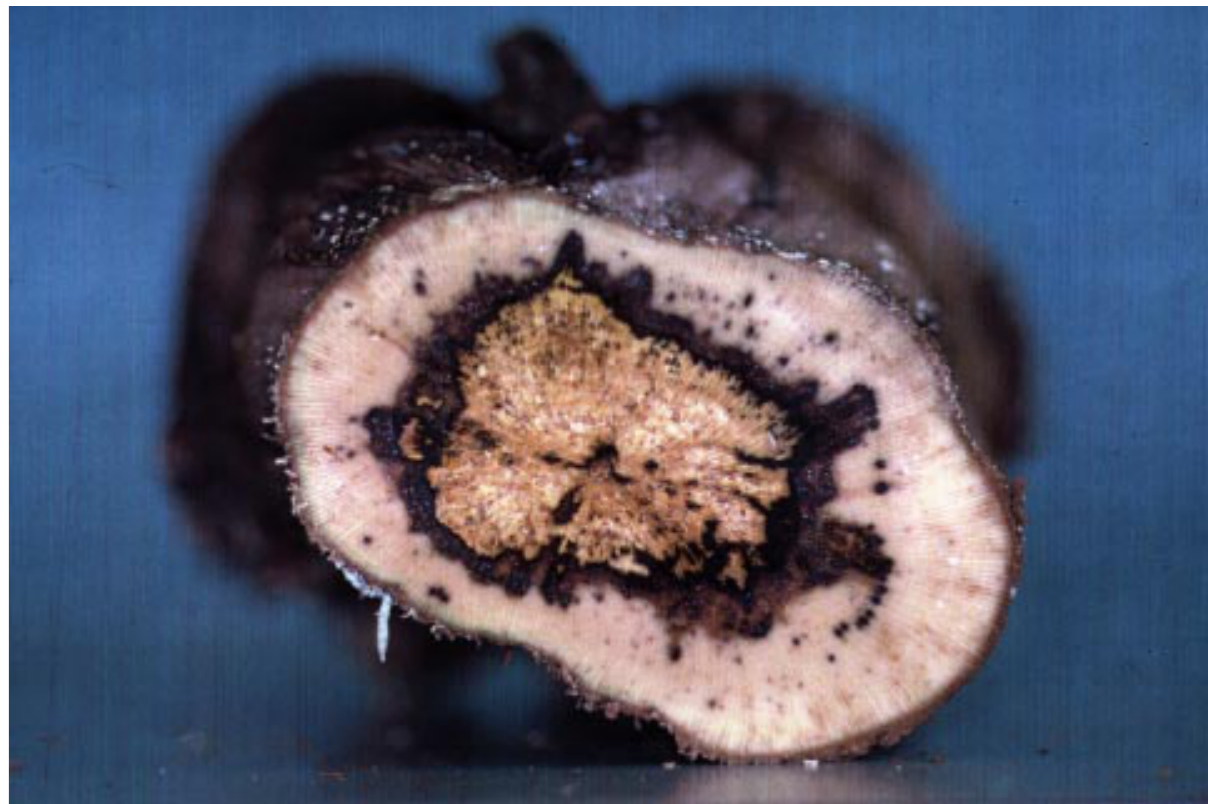
Fig. 8. Esca-like wood rot symptoms caused by Phellinus sp. (setose) and Phaeoacremonium chlamydosporum (VPRI 22081).